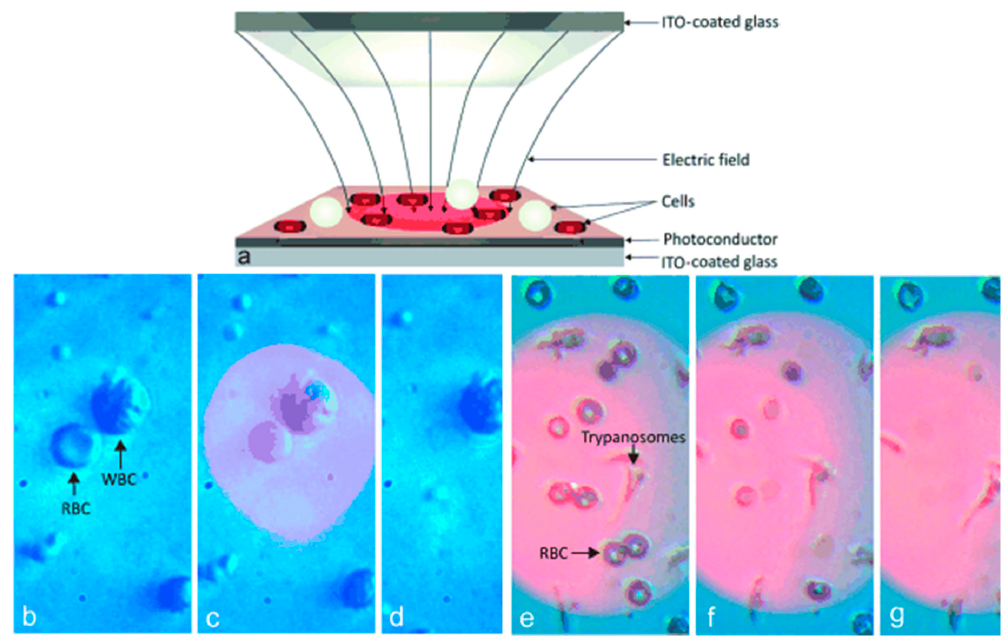
Figure 11. Optical cell lysis device: ( a ) cell lysis chip using optically induced dielectrophoresis (ODEP); ( b – d ) cell lysis of red blood cells in a mixture of white and red blood cells; and ( e – g ) lysis of red blood cells in a mixture of red blood cells and trypanosomes. Reproduced with permission from [71].